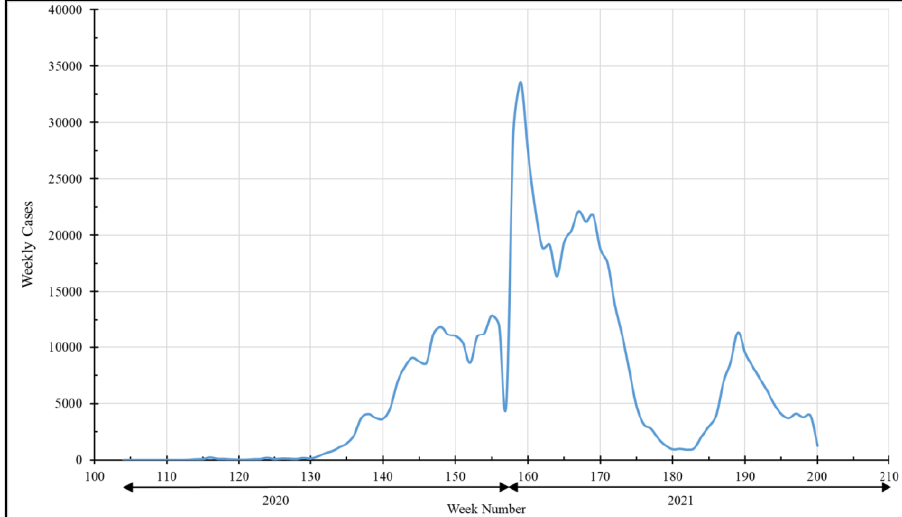
Fig. 2. Weekly New COVID-19 Cases in Lebanon – Source: Johns Hopkins Coronavirus Resource